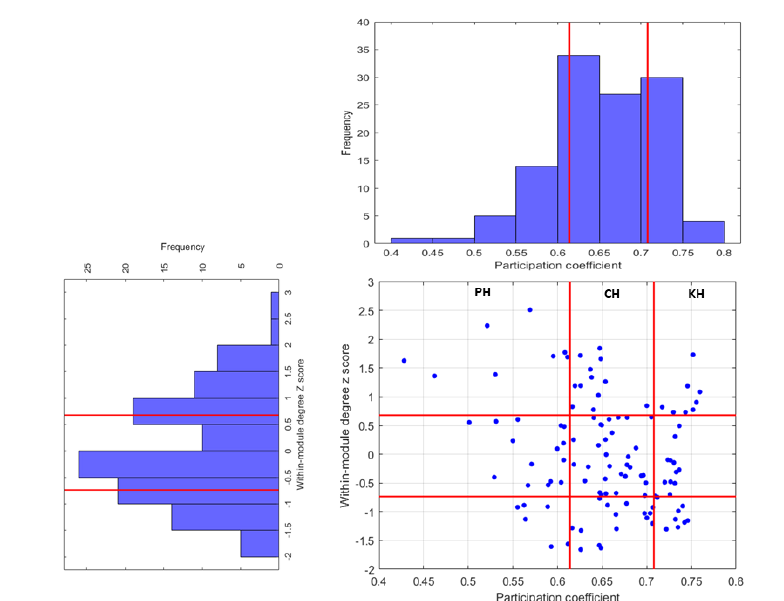
Figure 7. Cartographic presentation of nodes classification in the SYNC network of the first session. The red lines indicate the 25th and 75th of the two distributions of PC and z selected as the statistical thresholds to perform the plane